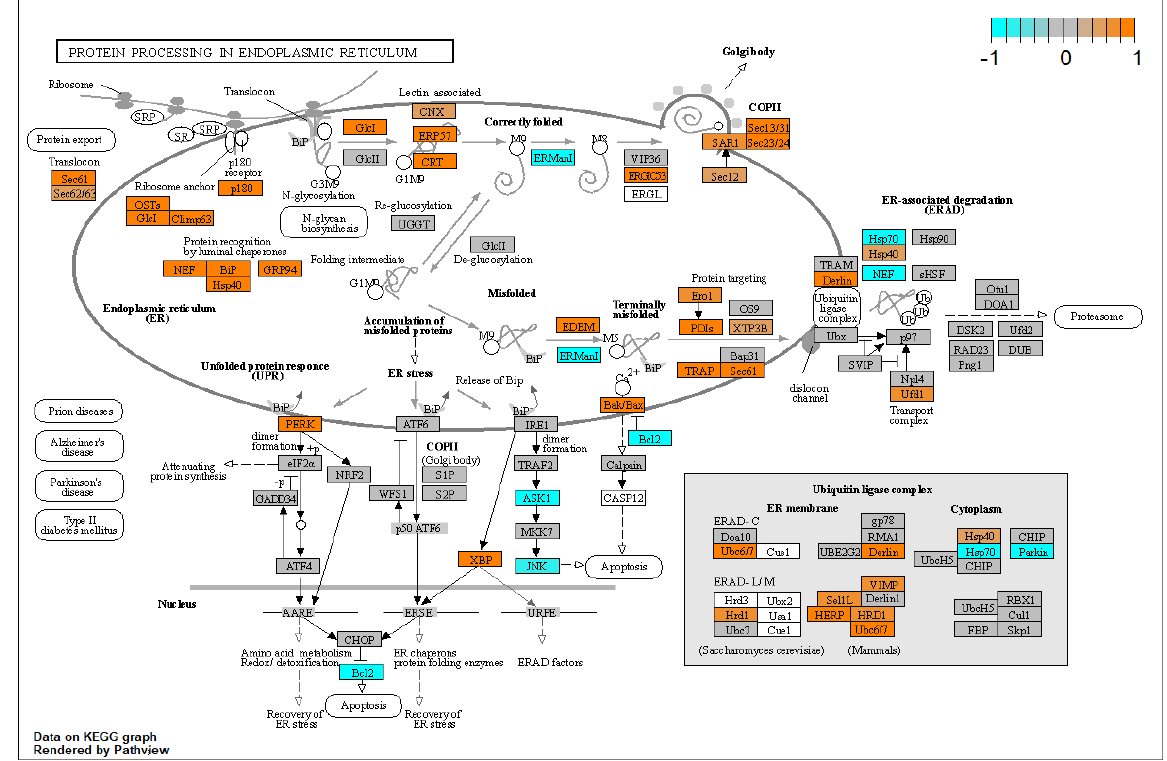
Figure 11. Annotation of differentially expressed genes in KEGG hsa04141 pathway. Differentially expressed genes in the hsa04141 pathway (protein processing in endoplasmic reticulum) have been annotated using R package pathview. Gene expression has been normalised to a range of [-1, 1] to enhance visibility in which orange corresponds to upregulation while cyan corresponds to downregulation. Grey coloured genes are expressed but not differentially so. White coloured genes were not found to be expressed in our dataset.